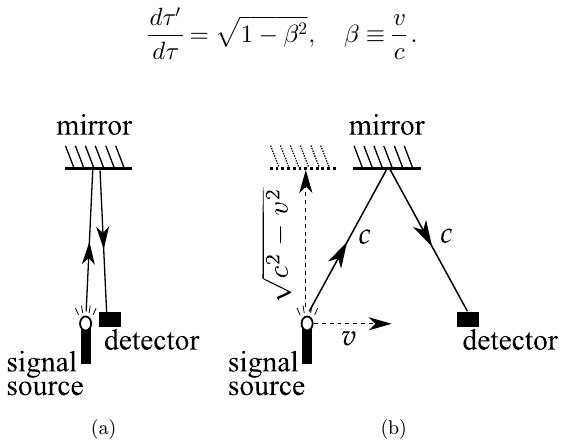
Fig. 2. An observer moving with velocity v with respect the fabric. The observer measures the round-trip time of a light signal traveling a ¯xed distance in a direction transverse to the motion. The situation is represented from the view point of (a) a moving observer and (b) a stationary observer, respectively. The p ffiffiffiffiffiffiffiffiffiffiffiffiffiffiffi c 2 (cid:1) v 2 e®ective transverse signal propagation speed is